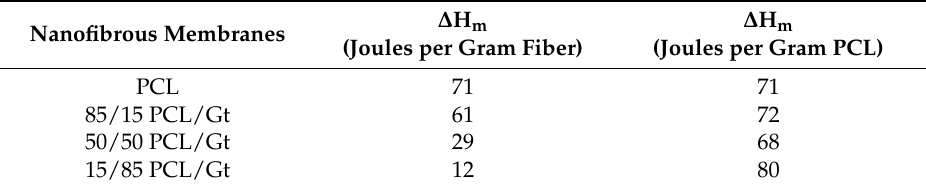
Table 1. Melting enthalpy measured using DSC (Figure 5a), as a function of total polymer mass and recalculated as a function of PCL